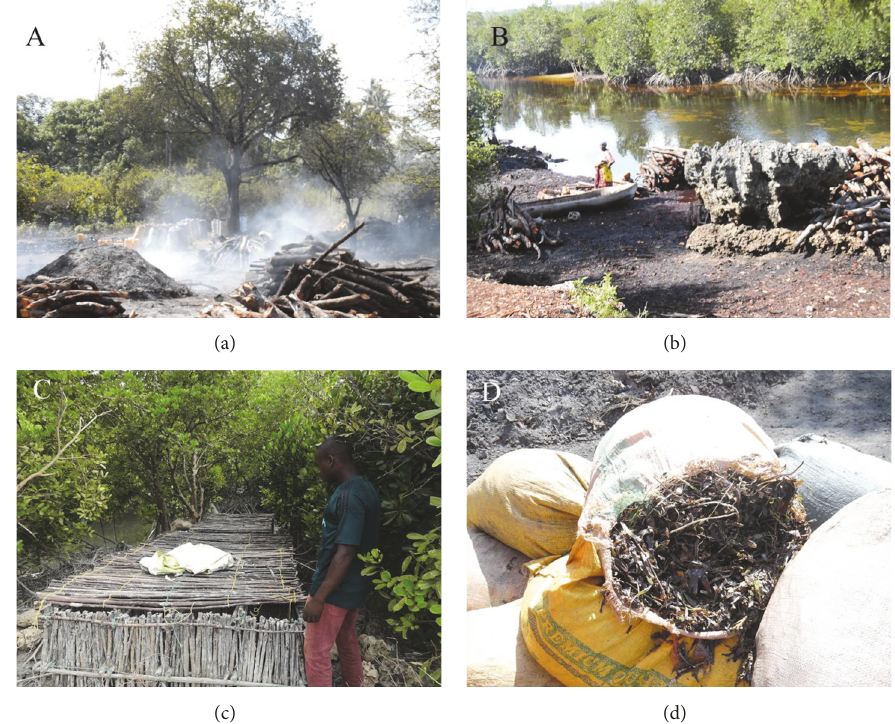
Figure 2: ((a) and (b)) mangrove clearing for charcoal making at Charawe village, (c) mangrove clearing for crab cage making at Kibele village, and (d) seagrass collected/parked for charcoal burning at Charawe village (photo by Amina Asiya Nchimbi).